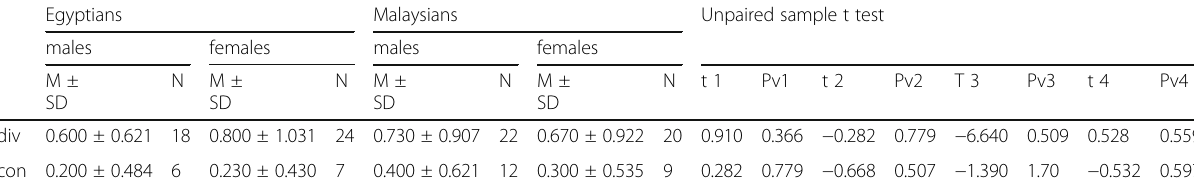
Table 3 Comparison of rugae unification status among both sexes of Egyptians and Malaysians Egyptians